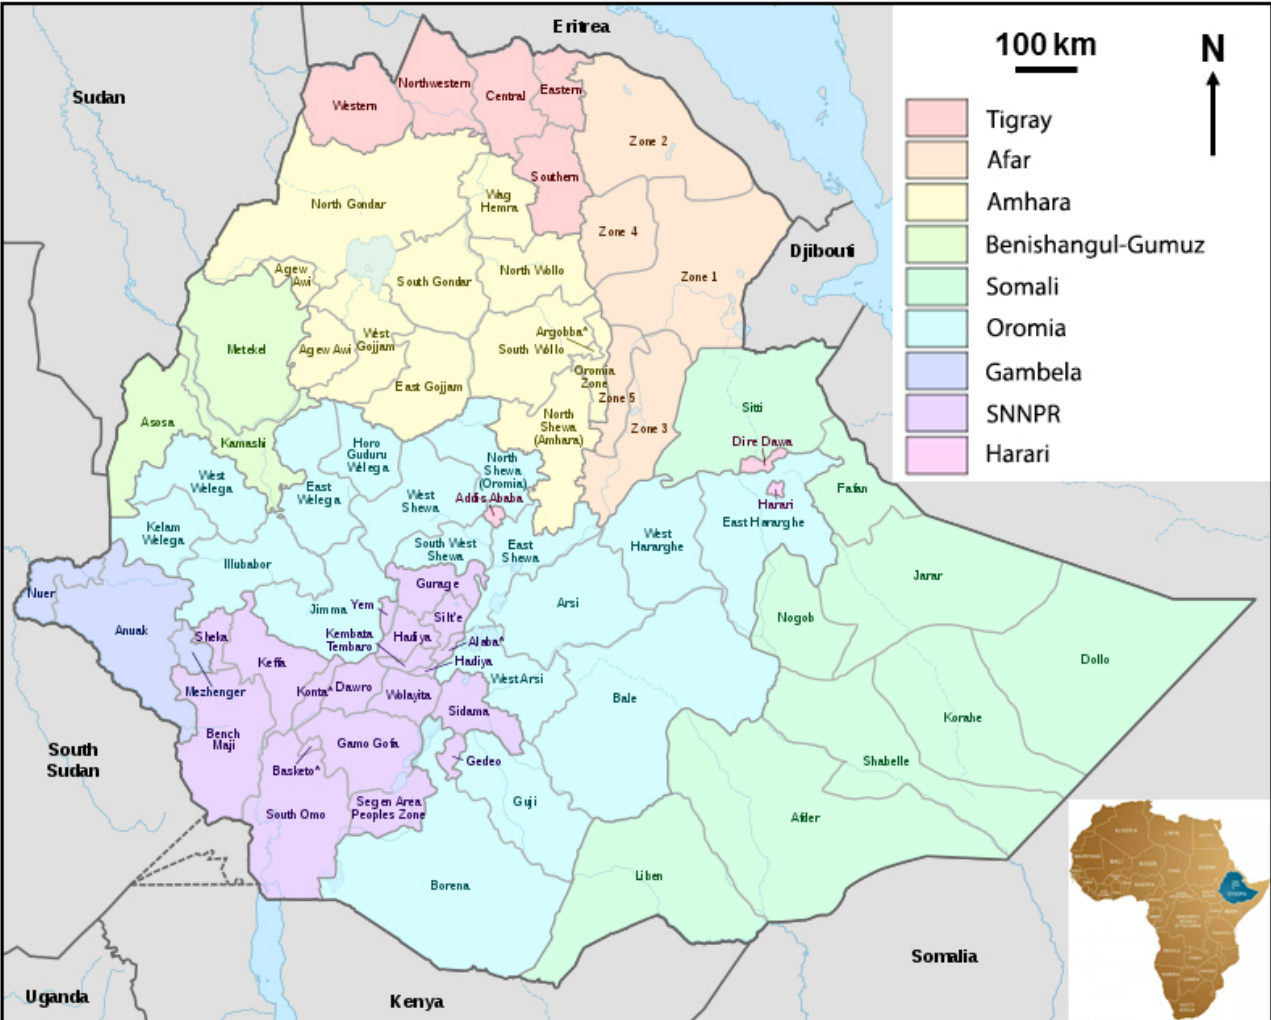
Figure 1. Map showing the geographical location of Ethiopia (modified from https://commons.wikimedia.org/wiki/File:Map_of_zones_of_Ethiopia.svg). SNNPR: Southern Nations Nationalities and People’s